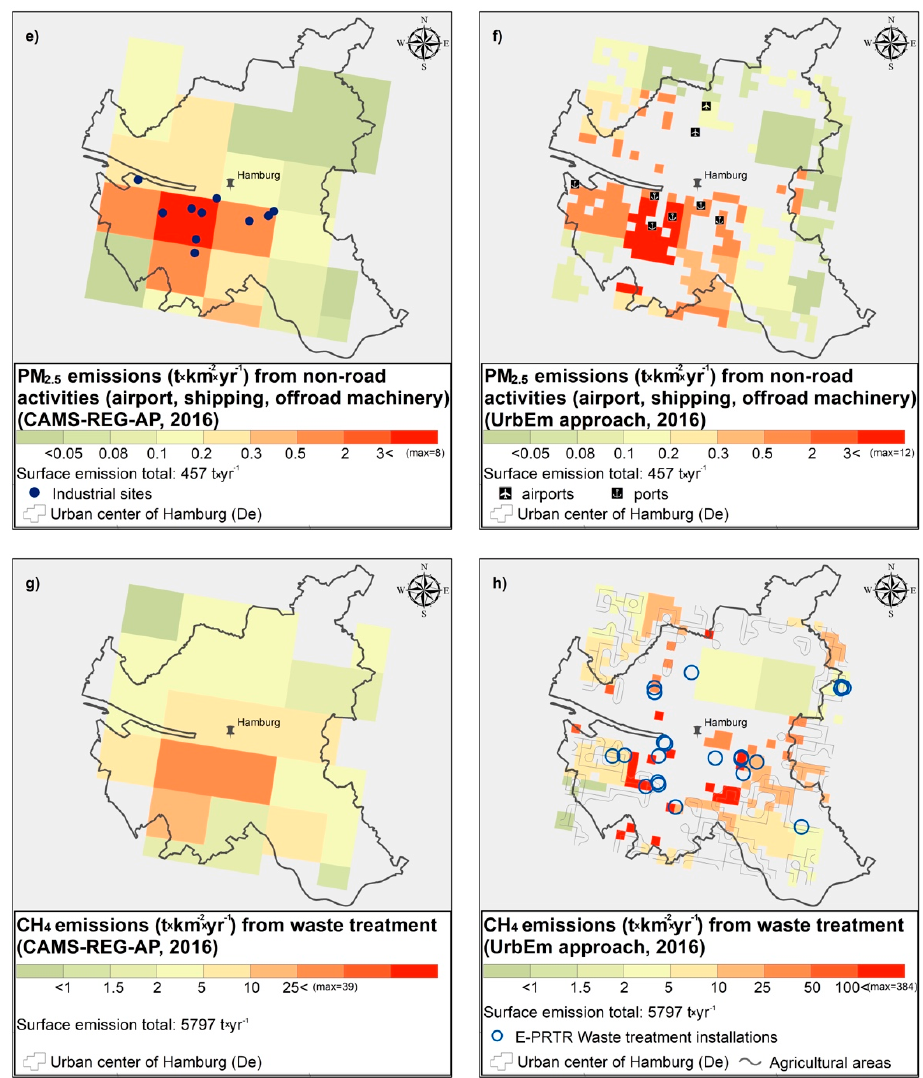
Figure 6. Representative air pollution emission fields for Hamburg, as originally provided by CAMS ( a , c , e , g ) and as produced by the UrbEm framework ( b , d , f , h ). Symbols and isopleths of the main proxies used per source type for the spatial disaggregation of CAMS toward the 1 km by 1 km grid are shown on the maps of the right column (UrbEm outputs).